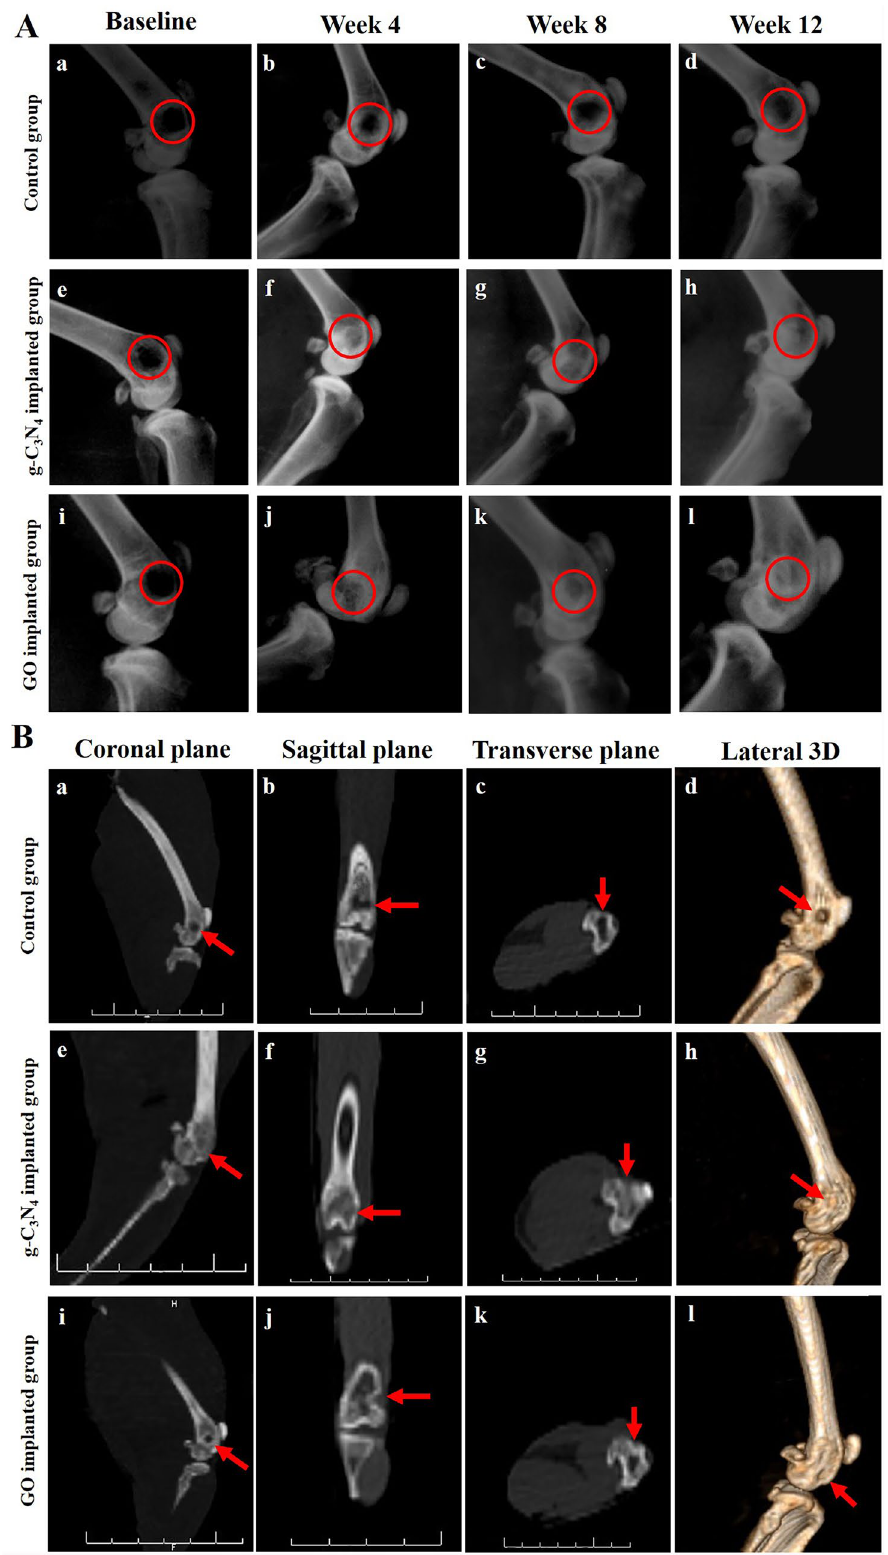
Figure 3. Radiological evaluation of bone repair. ( A ) Lateromedial radiographs of the defect site of control (a–d), g-C 3 N 4 implanted (e–h), and GO implanted (i–l) groups at different post-implantation times. ( B ) CT scanning of defect site of control (a–d), g-C 3 N 4 implanted (e–h), and GO implanted (i–l) groups at week 12 after